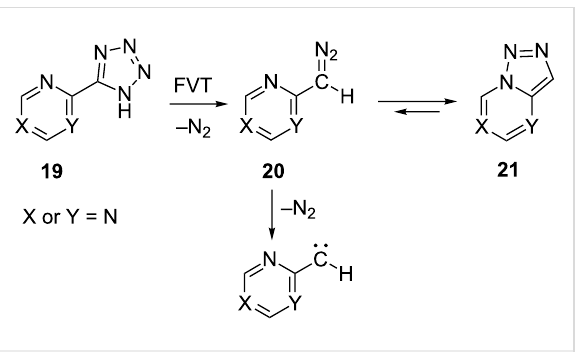
Scheme 7: Generation of pyrimidinyldiazomethanes and pyrimidinyl- carbenes.